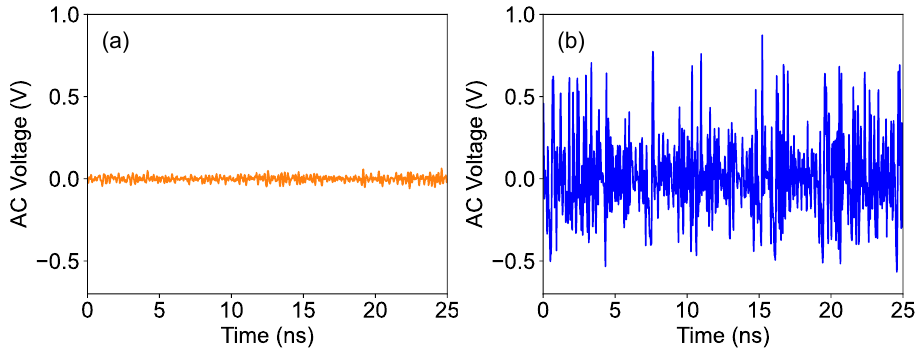
Figure 4. Fingerprint of the coherence collapse phenomenon on the intensity dynamics. The AC- coupled (average power is subtracted by a photodiode, with a low cut-off frequency of a few kHz) time traces are plotted in ( a ) for the solitary laser and ( b ) for the laser subject to delayed feedback. Colors correspond to the experimental conditions depicted in blue and orange colors in Figure 3. In ( b ), the tens of GHz laser’s optical linewidth is reflected in fast and chaotic oscillations of the corresponding time